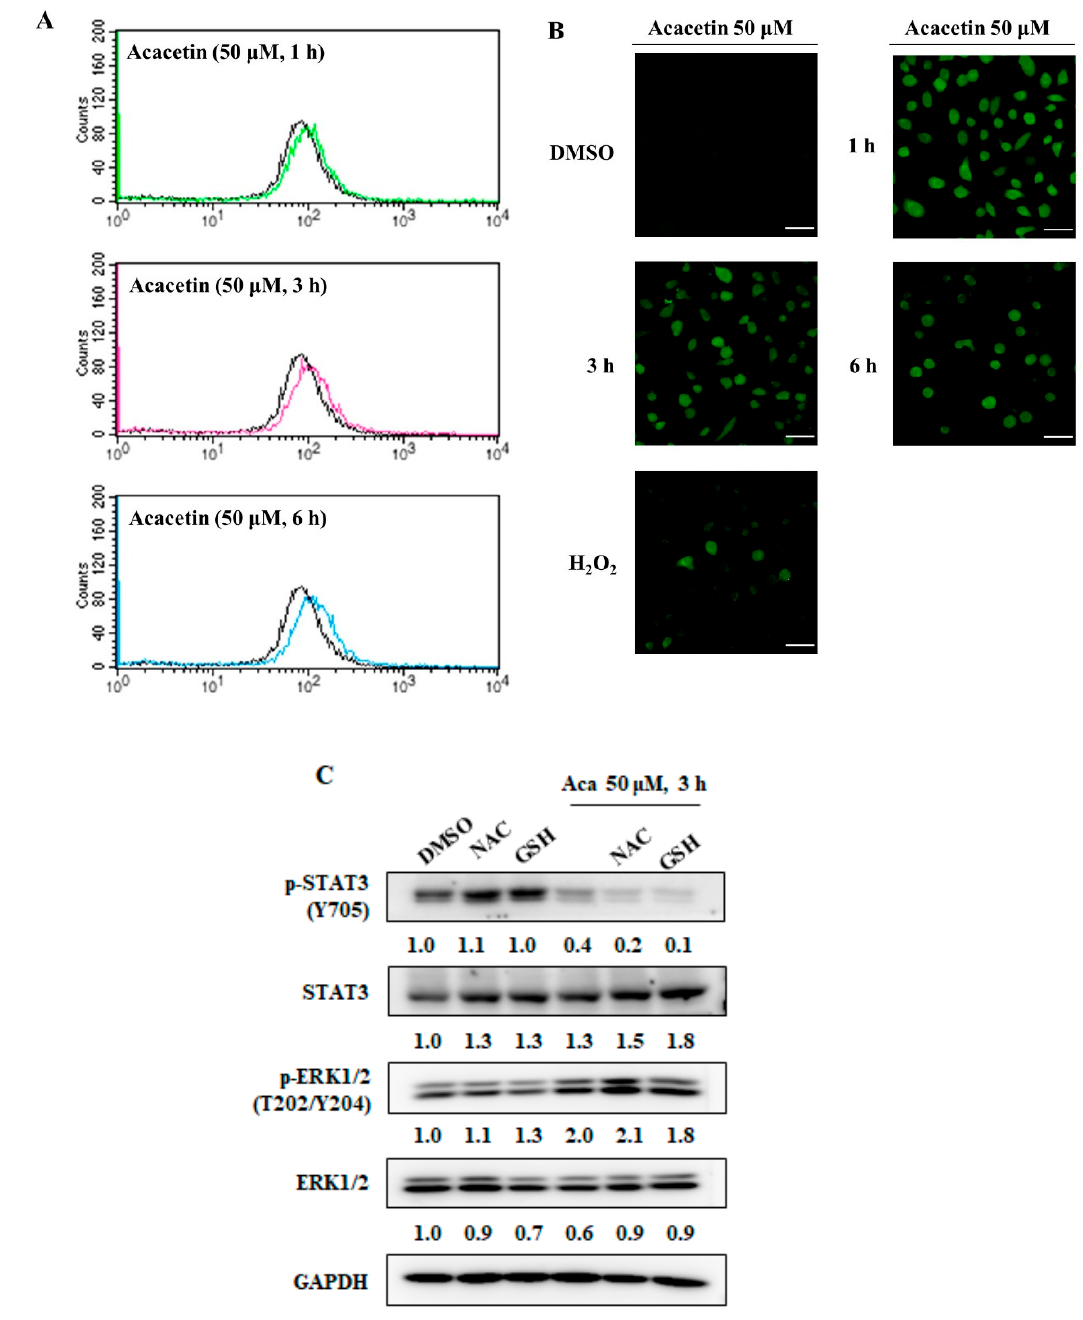
Figure 3. Acacetin promotes ROS generation. ( A , B ) DU145 cells were treated with acacetin (50 µ M) for 1, 3, or 6 h. After treatment, the intracellular ROS levels were measured with DCF-DA (10 µ M) using a FACSCalibur flow cytometer ( A ) and laser scanning confocal microscope. Scale bars, 50 μ m ( B ). ( C ) After pretreatment with NAC (5 mM) or GSH (5 mM) for 1 h, DU145 cells were treated with acacetin (50 μ M) for 3 h in the presence or absence of NAC or GSH. The expression levels of p-STAT3 (Y705) and STAT3 were analyzed by Western blotting. The band intensity of each protein was quantified using the MultiGauge program.